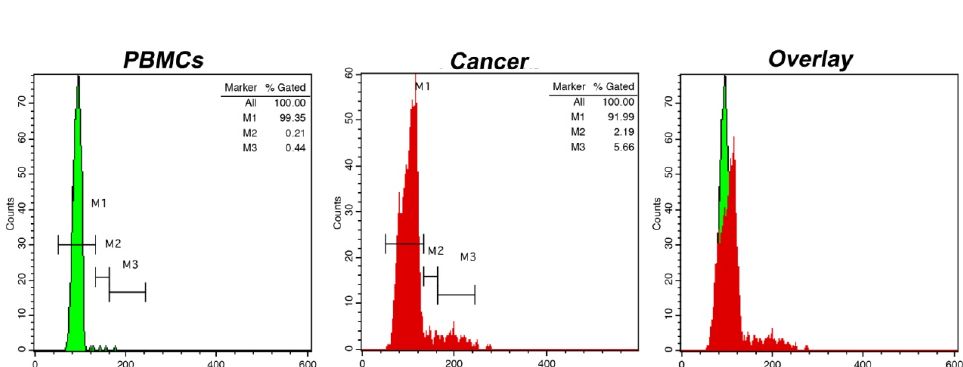
Figure 1. Cell cycle distribution analysis using intraoperative flow cytometry in a grade 1 meningioma. Markers M1, M2 and M3 represent G 0 /G 1 , S and G 2 /M cell cycle phases, respectively (absolute quantification of each marker is presented in the top right corner in each histogram). On the left of each figure the cell cycle distribution of peripheral blood mononuclear cells (PBMCs) is presented as a control. The presented case is diploid, with a DNA index = 1, while the tumor index (i.e., percentage of proliferative cells) was calculated at ~7%. In the overlay histogram, the G 0 /G 1 peak of cancer cells in red is discernible from that of normal cells in green.